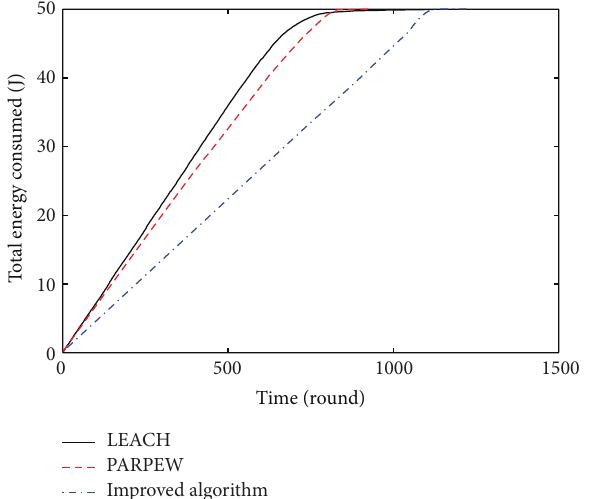
Figure 6: The changing curves of the energy consumption of network.